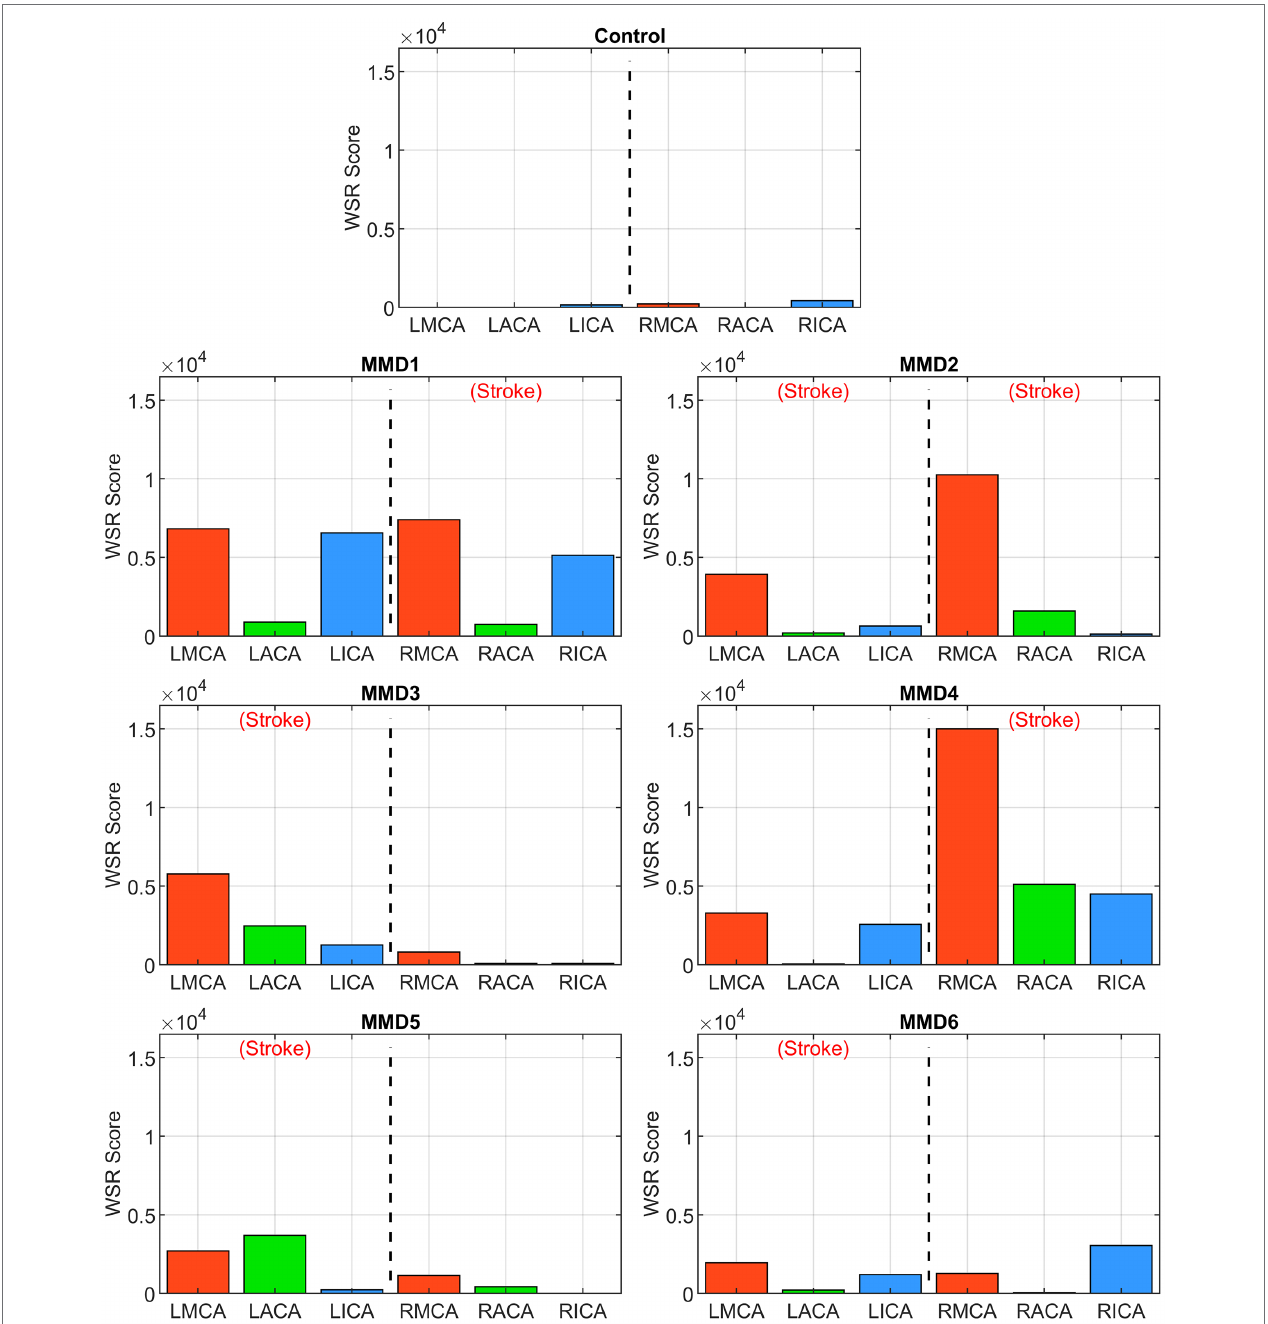
FIGURE 6 | WSR score in the left and right ICAs, MCAs and ACAs for the control subject and the six MMD patients we studied. The label (Stroke) indicates the side of primary